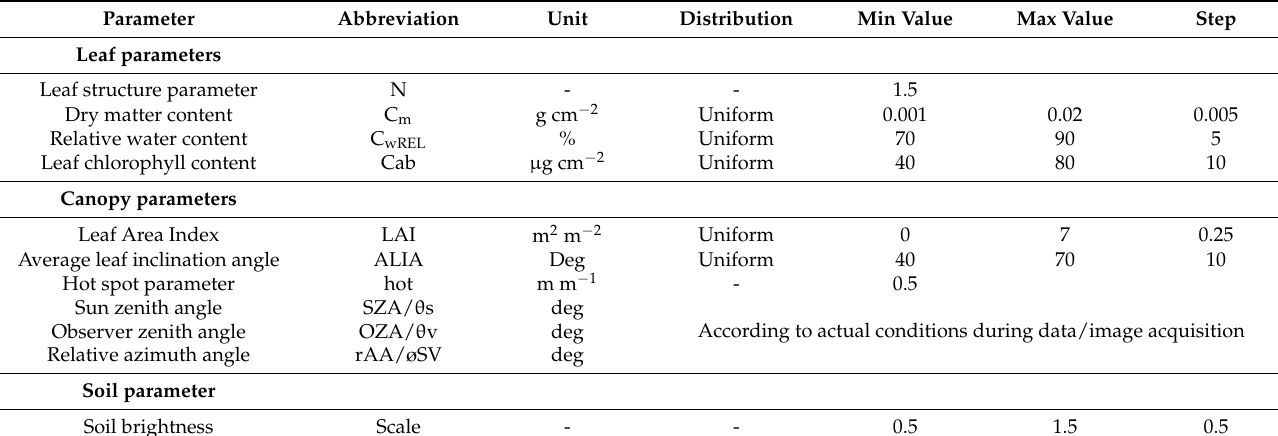
Table 3. Ranges of input parameters for the PROSAIL